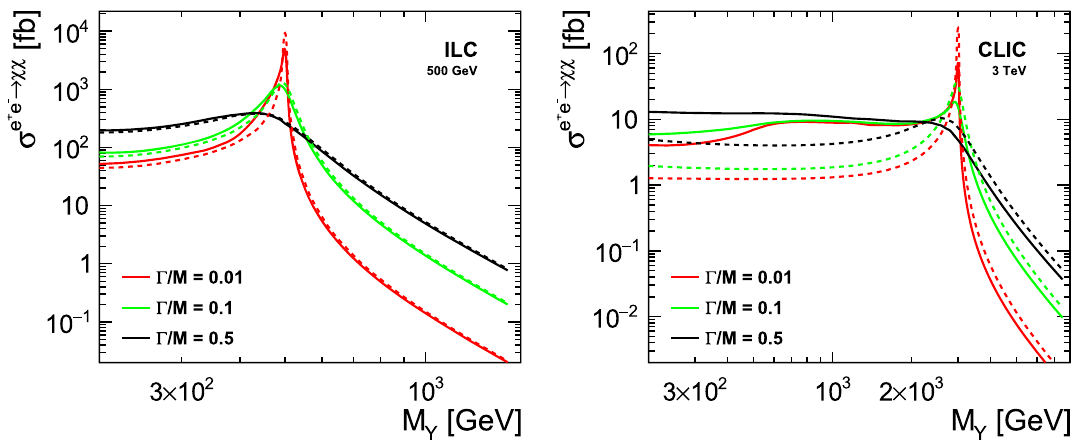
Fig. 2 Cross sections for DM production at 500GeV ILC (left) and 3TeV CLIC (right) as a function of the assumed mediator mass, M Y . Expectations for pair production of light Dirac DM ( m χ = 50GeV) are shown for scenario with vector mediator and different fractional mediator widths, as indicated in the plot. Results obtained with the expected collider luminosity spectra taken into account (solid lines) are compared with results assuming monochromatic beam (dashed lines). Mediator coupling to electrons is set to